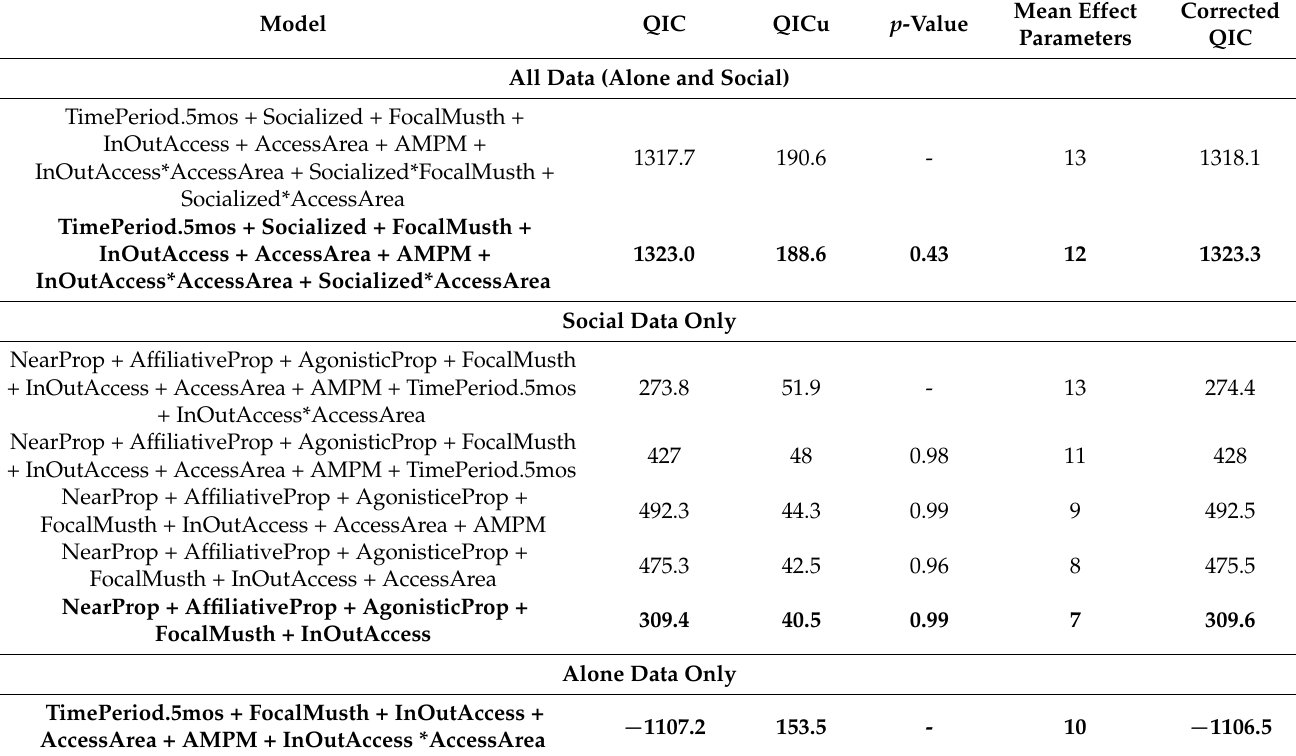
Table 4. Model Comparison Table for GEE of Pacing. Bold Indicates the Final Model.